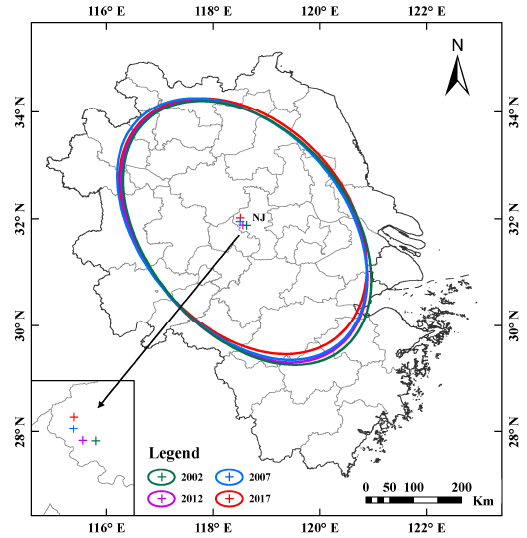
Figure 3. Trends in PM 2.5 concentrations during 2002–2017 period: ( a ) significance level of trends (increase means slope > 0 and decrease means slope < 0); and ( b ) slope values.